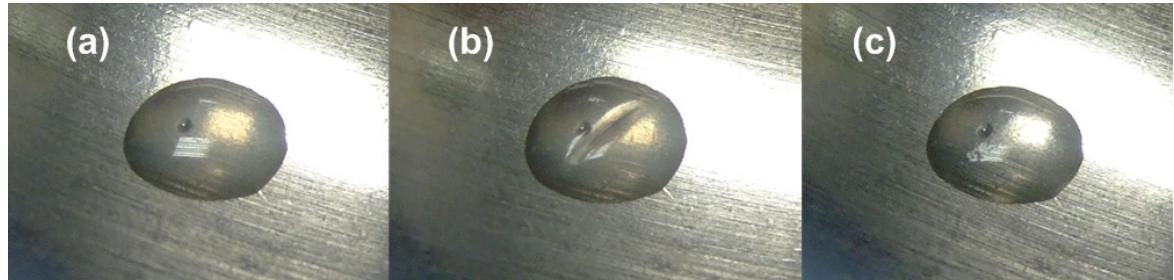
Figure 3. Thermally induced shape recovery due to surface tension in an EVA-based melting glue droplet. ( a ) Original shape; ( b ) after indented for a line; and ( c ) after heating for shape